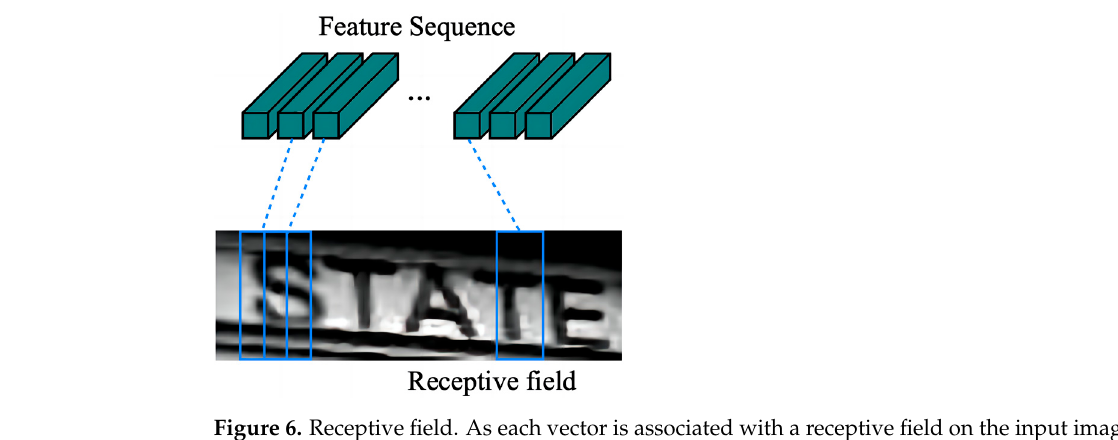
8 of 16 Figure 5. Flow diagram of CRNN algorithm. The feature sequences of the input image are first obtained in the convolutional layer